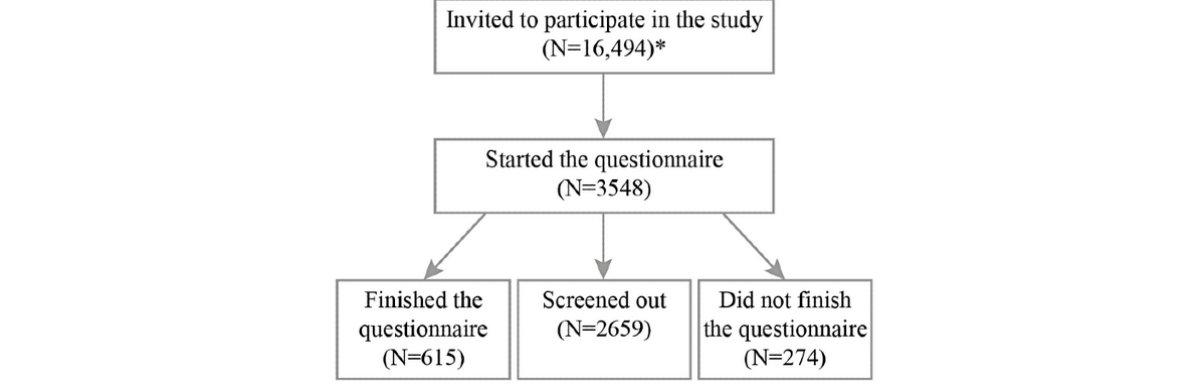
Figure 1. Disposition of survey respondents. *Respondents who had agreed to receive invitations to participate in